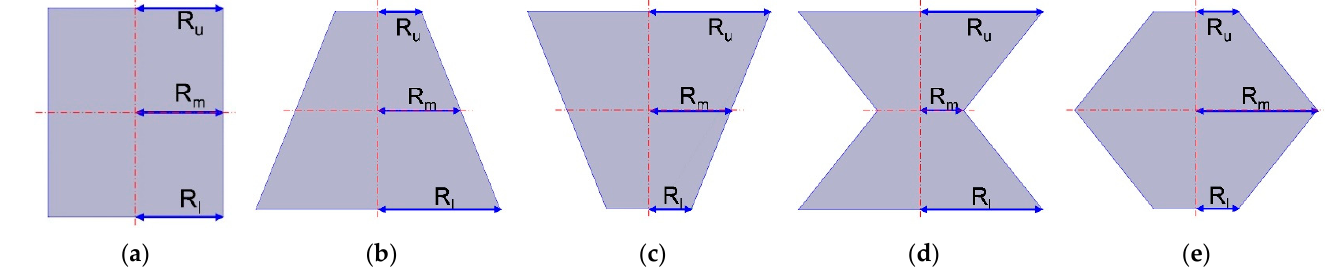
Figure 2. The tangent sectional shape of air domain in aperture for various tangent sectional shapes. ( a ) Rectangle; ( b ) common trapeziform; ( c ) reverse trapeziform; ( d ) dumbbell; and ( e ) olive.